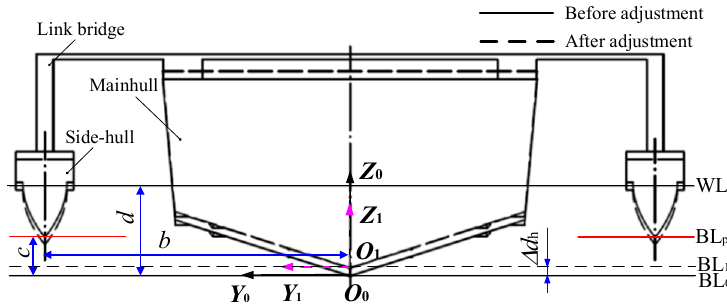
distance between main hull BL and demihull BL, ∆ dh represents the variation of BL posi ‐ tion for the main hull before and after adjustment. Six different vertical locations of the side ‐ hulls were obtained, shown in Figure 28b, corresponding to the six draft ratios D d /T m (NOs. 1–6) listed in Table 9, where S m and S d represent the waterline (WL) areas of the main hull and twin side ‐ hulls, respectively. Figure 28. Different ( a ) longitudinal locations; ( b ) vertical locations of the side ‐ hulls in the TFS. Table 8. Six longitudinal locations of side ‐ hulls in the TFS.